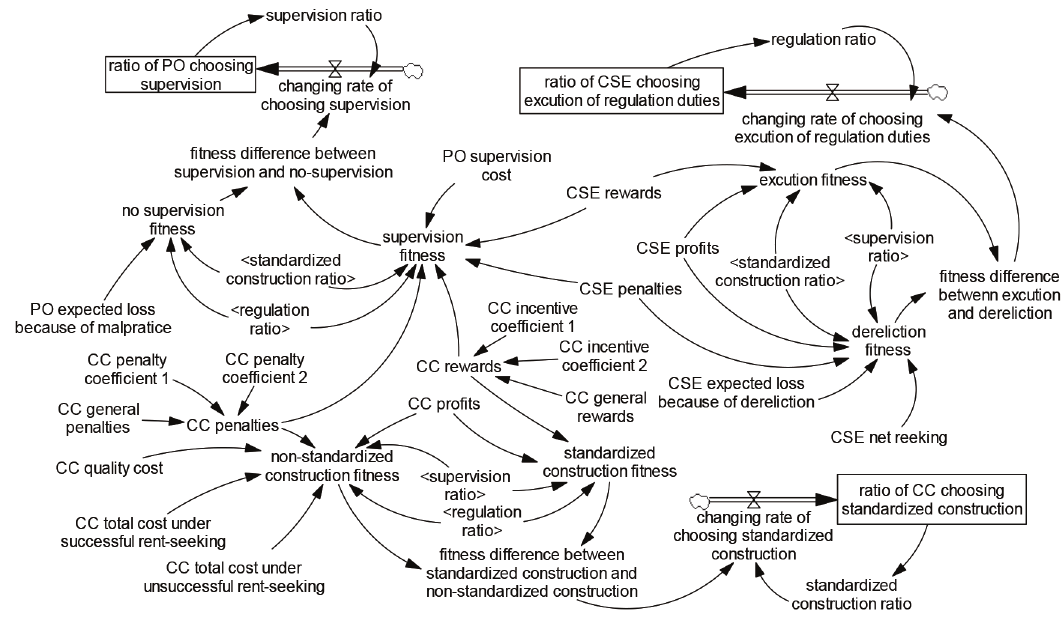
Figure 12. Evolutionary game SD model under the dynamic penalty–reward control scenario